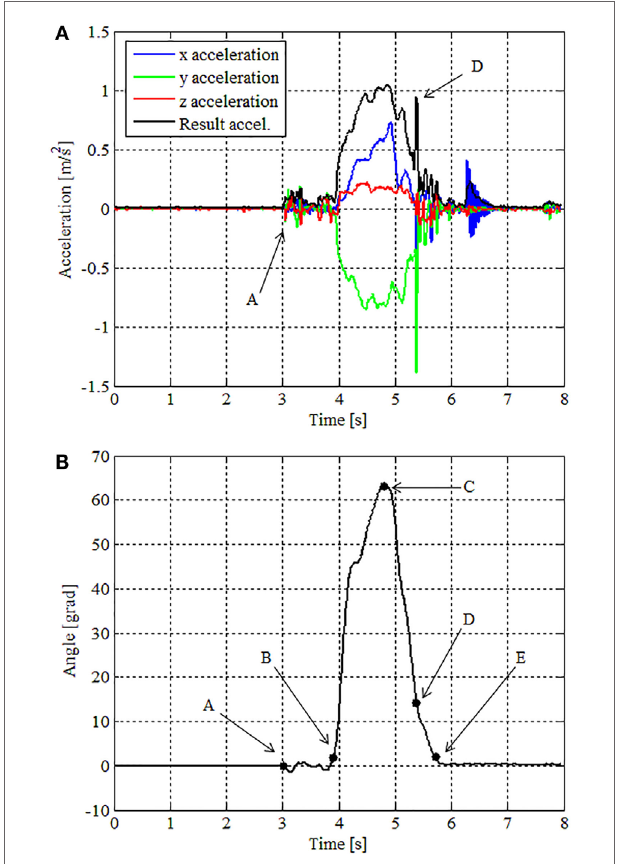
FIgURe 6 | (A) Accelerations as a function of time for the trial taken as example; (B) Euler angle Y (sagittal plane) for the same trial of (A) .